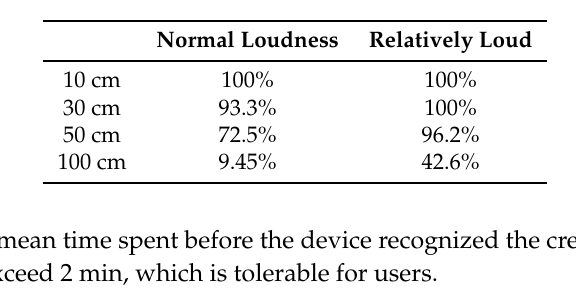
Table 3. Precise rate at different distances.